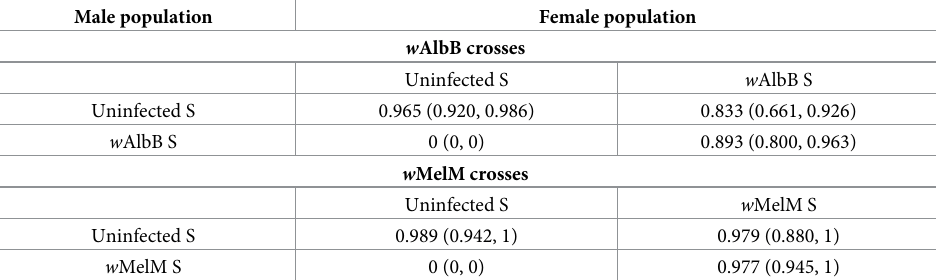
Table 1. Cytoplasmic incompatibility induction by w AlbB-infected and w MelM-infected males in Aedes aegypti from a Saudi Arabian background. Median egg hatch proportions and confidence intervals (lower 95%, upper 95%) are